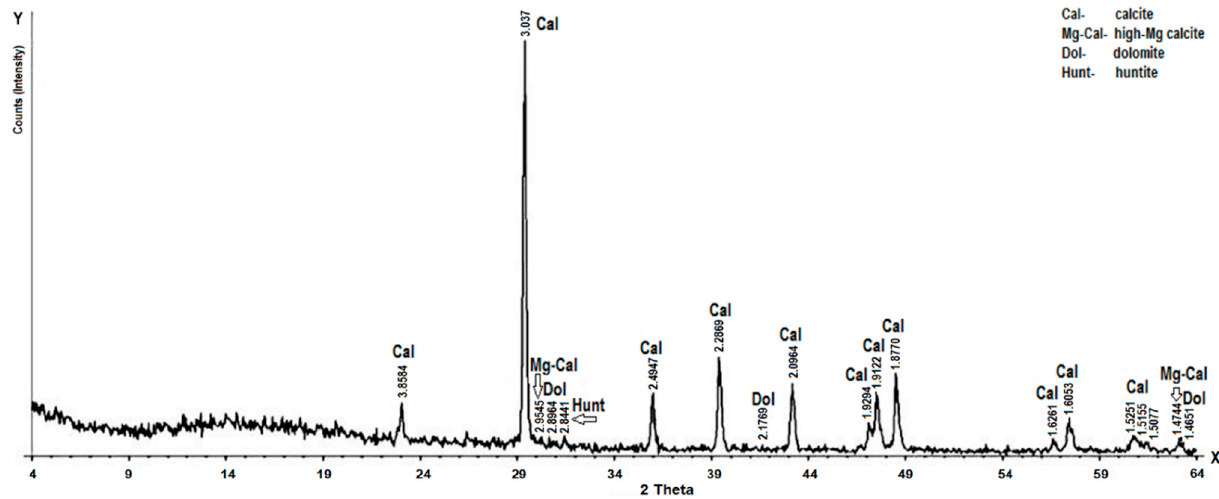
Figure 4. Diffractogram of sample S7, limestone of the Dziewkowice Unit taken in the Szymiszów Quarry [24].